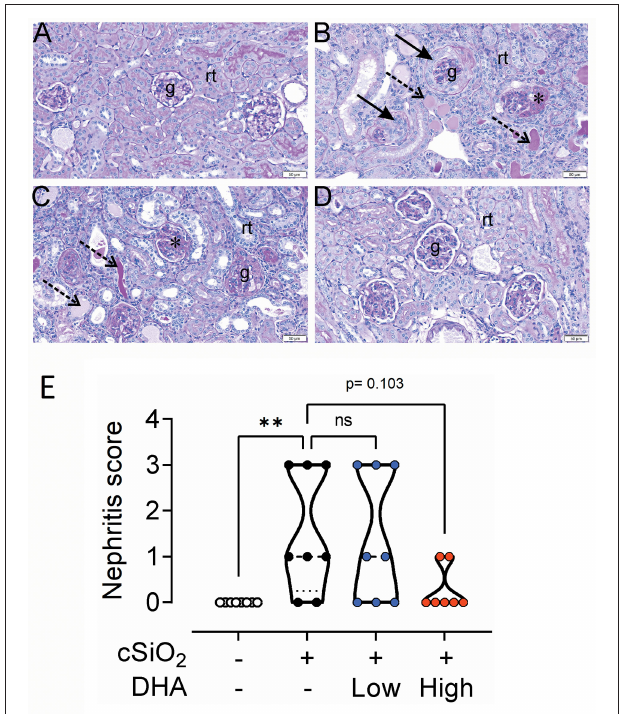
FIGURE 10 | High DHA diet slightly inhibits cSiO 2 -triggered glomerulonephritis. Representative periodic acid Schiff-stained kidney tissue sections (A–D) from mice fed control diet and intranasally instilled with saline vehicle (Veh/CON; A ), fed control diet and intranasally instilled with cSiO 2 (cSiO 2 /CON; B ), fed 0.4% DHA diet starting one week after the end of the intranasal cSiO 2 instillations (cSiO 2 /low DHA; C ), or fed 1.0% DHA diet starting one week after the end of the intranasal cSiO 2 instillations (cSiO 2 /high DHA; D ). Kidney histopathology consisting of shrunken glomerular tufts, mesangial matrix expansion, in glomeruli (asterisk), crescent-shaped masses of proliferating cells in Bowman’s space (solid arrow), regenerative tubular epithelium, and tubular protein accumulation (dotted arrows) were evident only in cSiO 2 -instilled mice that received no or low DHA treatment (D) . No renal histopathology was present in Veh/CON or cSiO 2 /high DHA treatment. g, glomerulus; rt, cortical renal tubules. (E) Semiquantitative scoring based on histopathology conducted as described in Materials and Methods. ** p ≤ 0.01, ns = not significant.